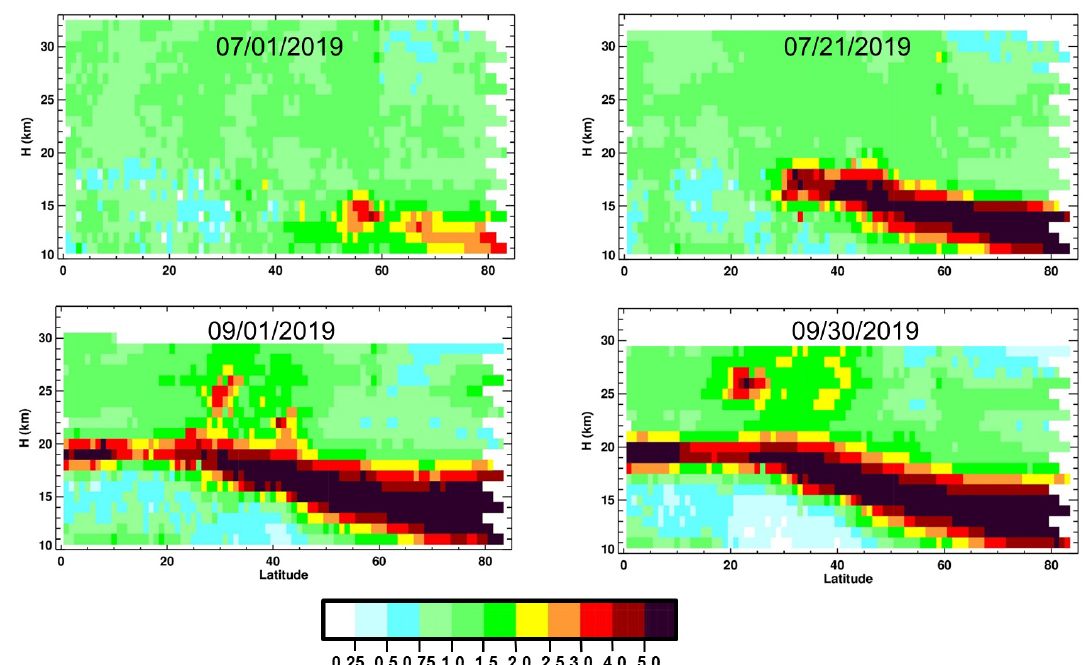
Figure 10. The ratio of the zonal mean, daily average aerosol extinction for the indicated dates after the Raikoke eruption to the averaged aerosol extinction immediately prior to the eruption shows the evolution of the volcanic aerosol in the background aerosol layer (13–20km) and the occurrence of the CCC near 25km from OMPS LP data.